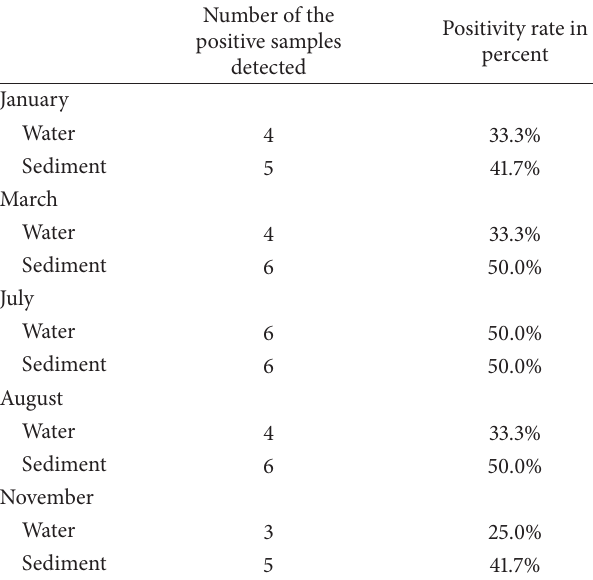
Table 2: Sample detection results for the 12 sites in Yunlong Lake, Xuzhou,